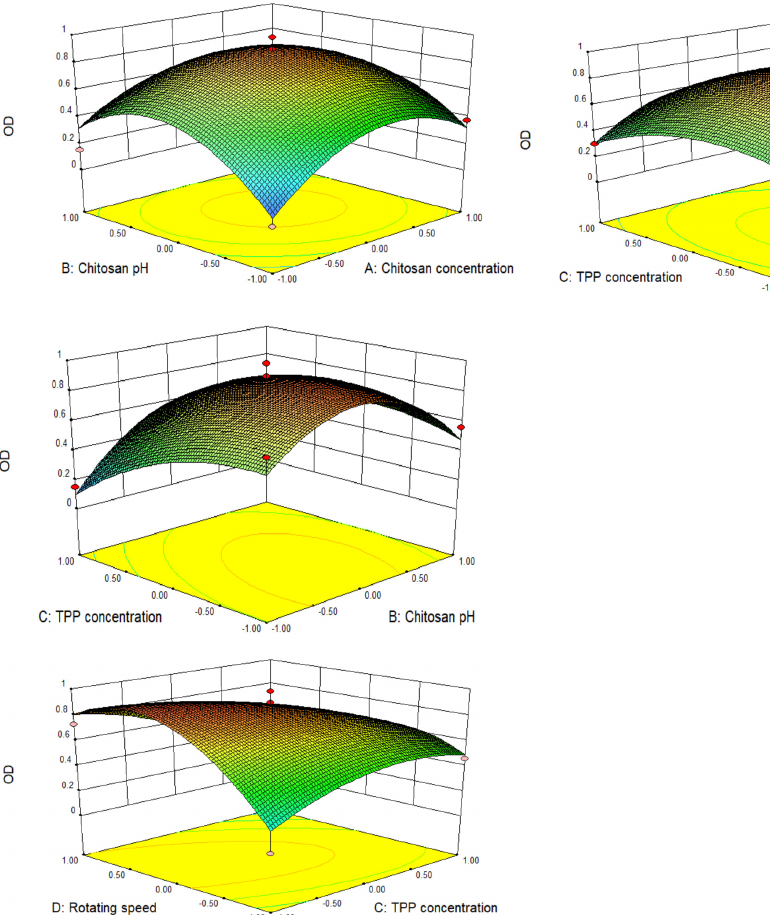
Figure 1. Contour map and 3D surface map of the four factors of effect value OD and A, B, C and D.